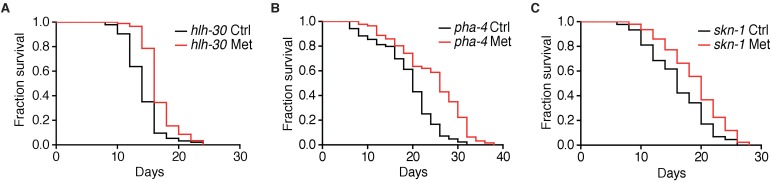
Metformin promotes longevity through a pathway additive to TORC1 inhibition.(A–C) Lifespan analysis of hlh-30, pha-4 or skn-1 loss-of-function mutants in the presence or absence of metformin.